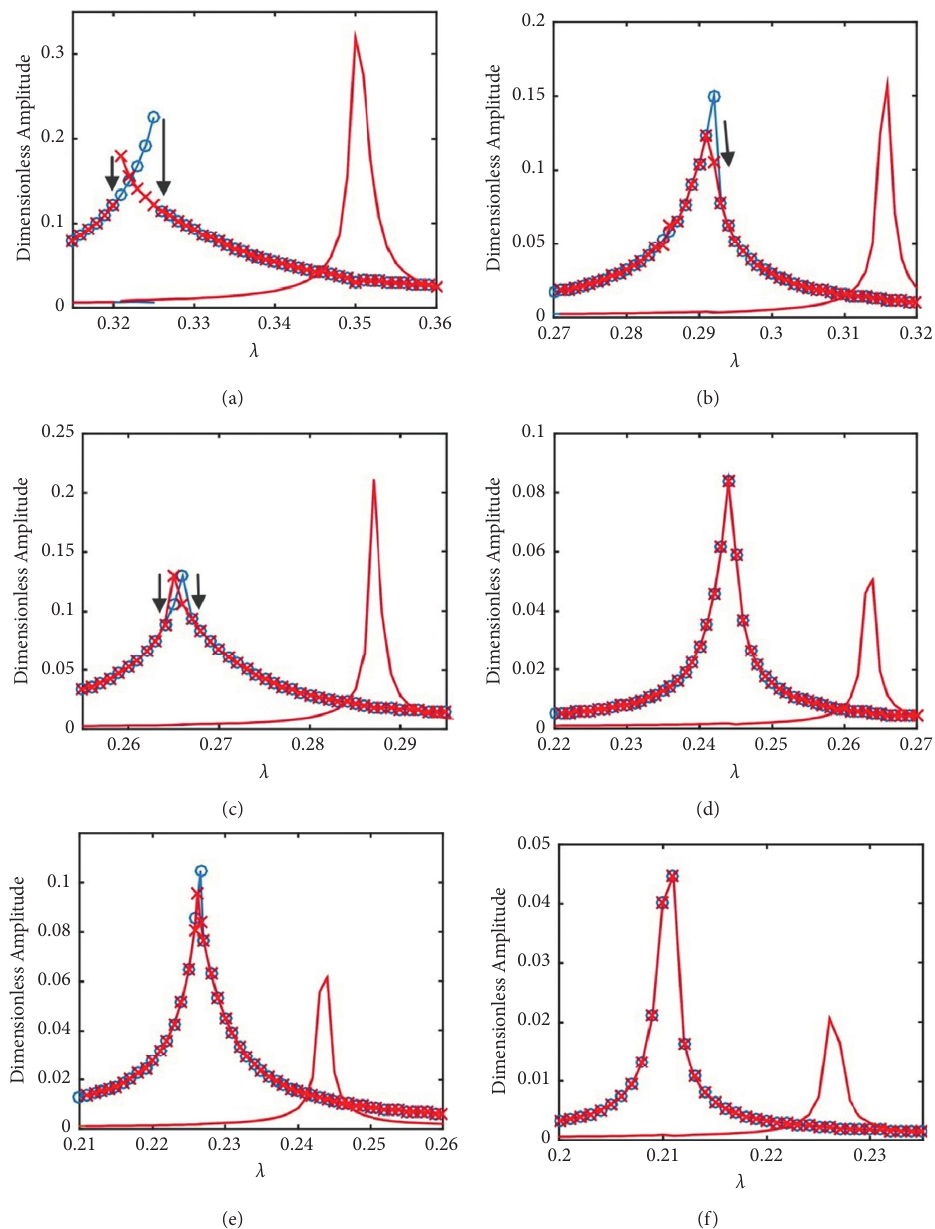
Figure 6: Spectrums of the responses at (a) λ � 2 . 05, (b) λ � 2 . 86, (c) λ � 2 . 97, and (d) λ � 3 . 58 when N